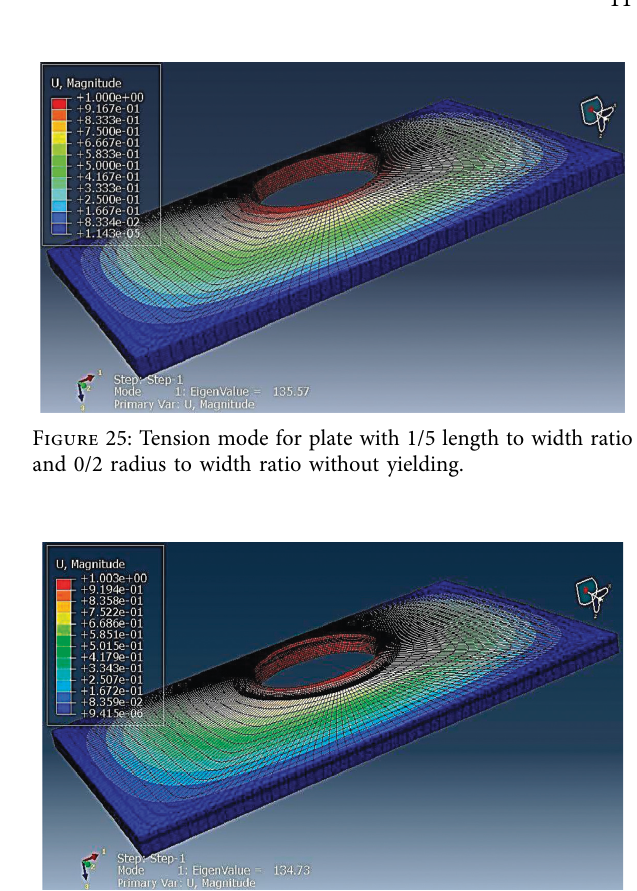
Figure 26: First tension mode for plate with 1/5 length to width ratio and 0/2 radius to width ratio with 0/25 yielding ratio.